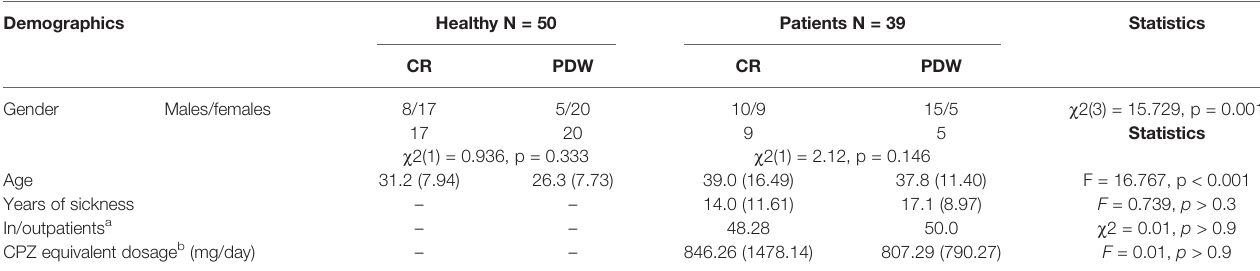
TABLE 1 | Demographic characteristics of the group of patients with schizophrenia and healthy